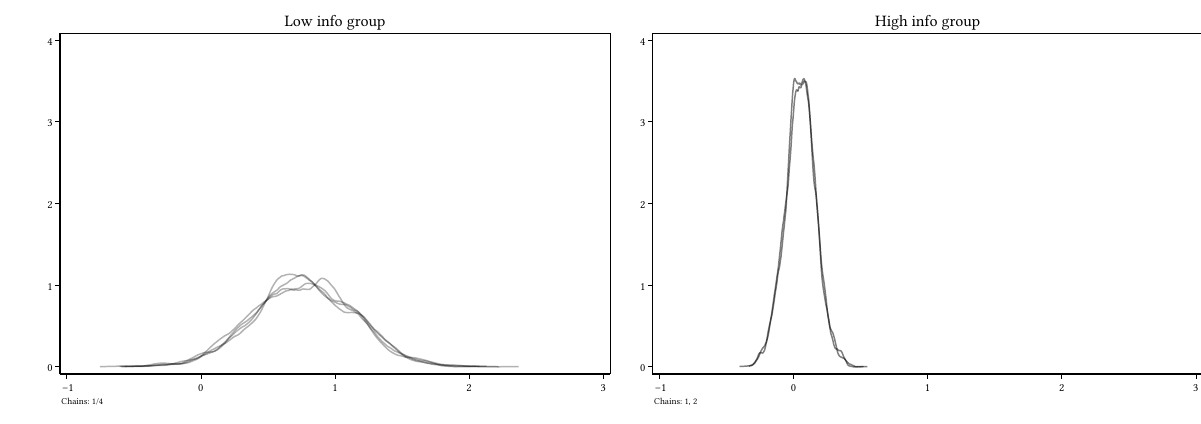
Figure 4. How awareness of the market price influences response to the extremes. Table 8. δ ’s sensitivity to considering the market price. Experimental Group H Odds Ratio Result Low Info H A 49.6 Strong High Info H A 2.1